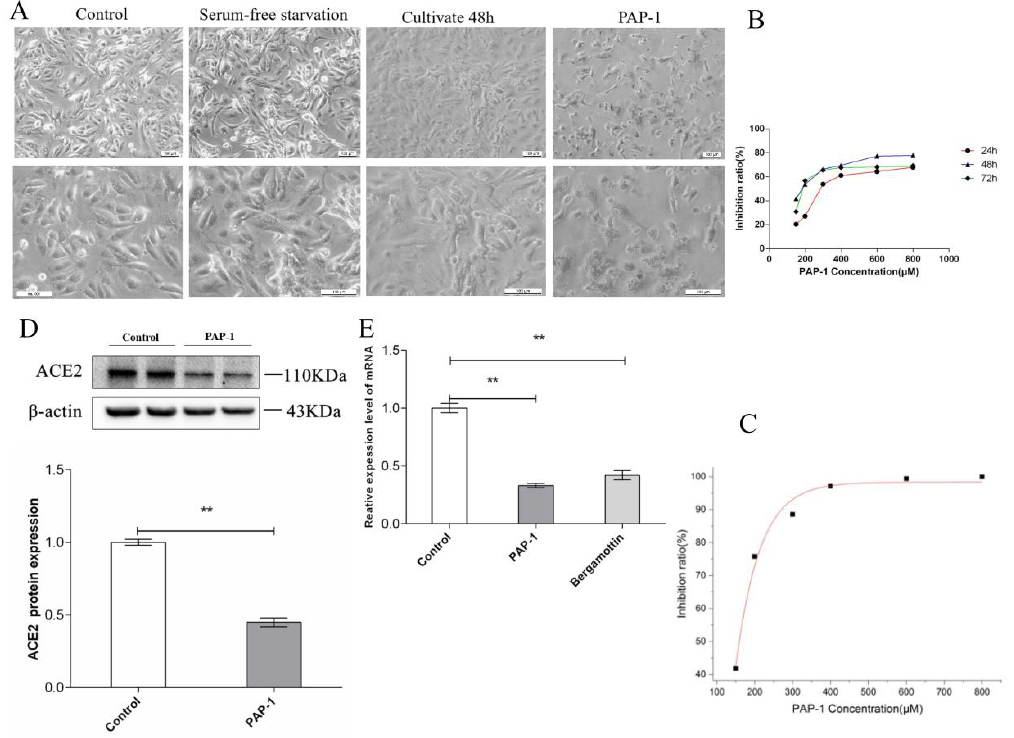
Figure 5. Effects of PAP-1 viability of the AT-II cells and cell morphology. ( A ) AT-II were treated with the indicated concentrations of PAP-1 for 24 h for cell morphology ( × 100 and × 200). ( B ) Effects of bergamottin on viability of AT-II cells for 24, 48,and 72 h by CCK-8 kit, comparison of cell viability at 48 h of PAP-1, the indicated concentrations of PAP-1 for 48 h. ( C ) After 48 h treatment of AT-II cells with PAP-1 at 150, 200, 300, 400, and 800 µ M, cell viability (by CCK-8 assay, n = 5) of both cell types was inhibited in a concentration-dependent manner in accordance with the Hill equation: y = ax b /(c b + x b ). The IC50 for AT-II cells were calculated as 150 µ M. An amount of 150 µ M PAP-1 suppressed cell viability in AT-II cells, after which the viabilities stabilized. Accordingly, 150 µ M was chosen as the PAP-1 dose for subsequent experiments. ( D ) Western blot detection of expression of ACE2 proteins in AT II cells. Normalized to β -actin. ** p < 0.01, PAP-1 vs. Control, ACE2 protein after administration of PAP-1 were signifificantly lower than the control group. ( E ) mRNA expression levels of ACE2 relative to AT-II cells with PAP-1. The data in the figure was measured in the following manner: Unpaired data in compliance with normal distribution and homogeneity between two groups and were compared using an unpaired t test. The experiment was independently repeated three times.